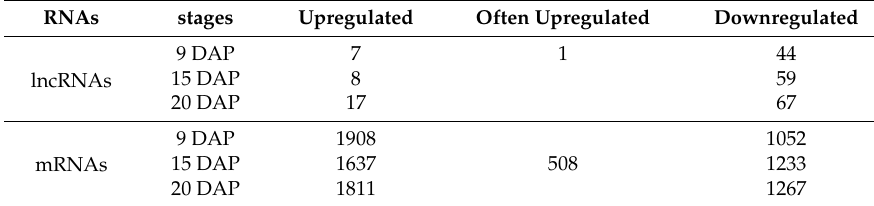
Figure 2. Expression profiles of lncRNAs during embryo and endosperm development. ( A ) Cluster heat map of all lncRNAs expression at different stages of embryo development; ( B ) Cluster heat map of all lncRNAs expression at different stages of endosperm development; ( C ) Scatter plots showing differentially expressed lncRNAs in the embryo (black points) and endosperm (red points) at different stages. ( D ) Differentially expressed lncRNAs between embryo and endosperm at different stages; ( E ) Hierarchical clustering showing often up ‐ and downregulated lncRNAs in the two tissues. Table 1. Differentially expressed long non ‐ coding RNAs (lncRNAs) and mRNAs in embryos and endosperm. RNAs stages Upregulated Often Upregulated Downregulated